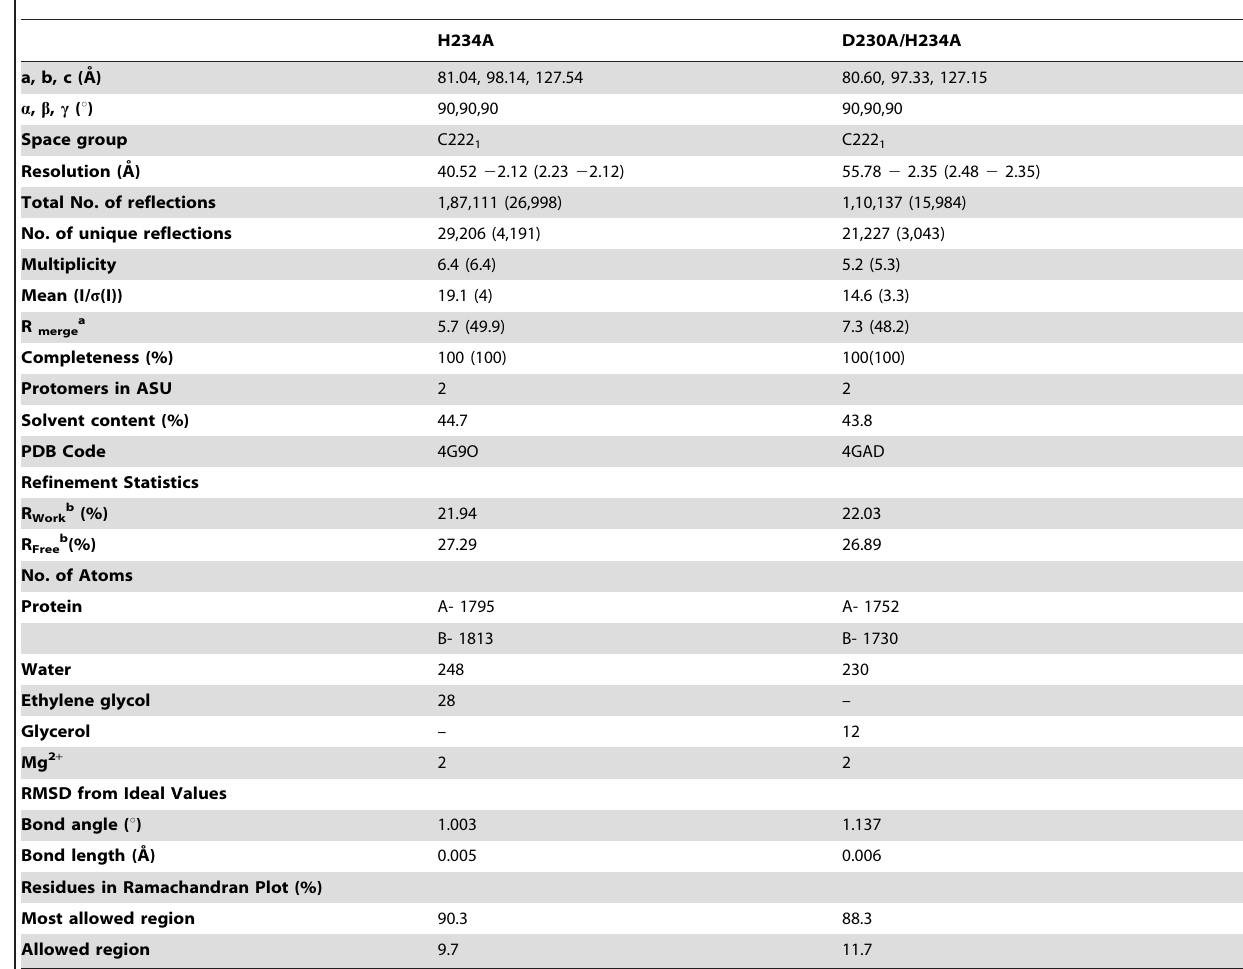
Table 1. Data Collection and Refinement